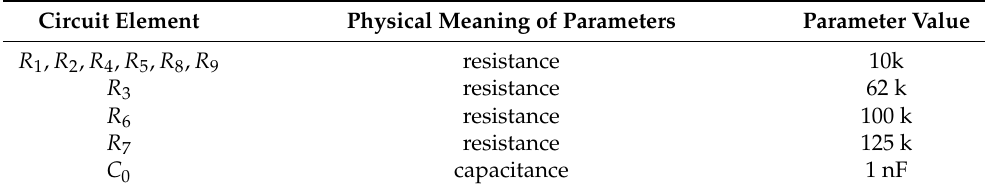
Table 1. Value of circuit elements of fractional-order memristor. Physical Meaning Circuit Element